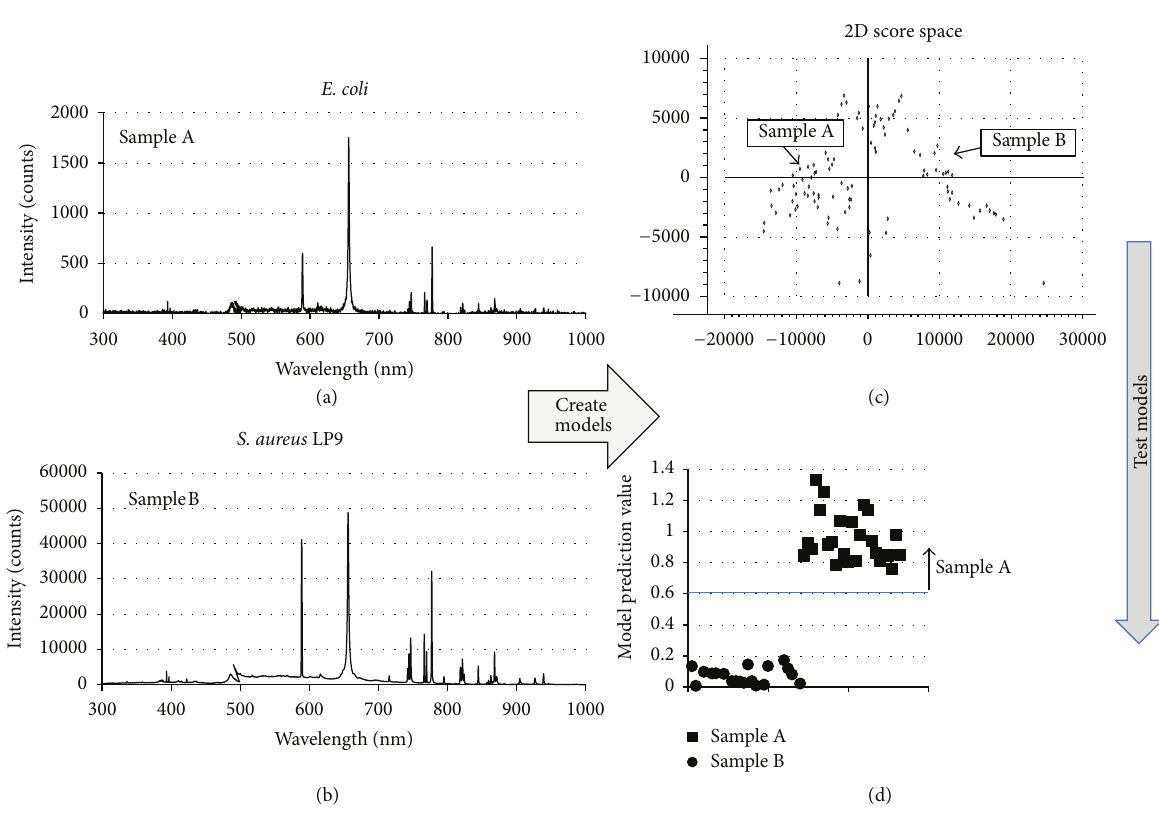
Figure 1: (a), (b) Examples of LIBS spectra used to create a discrimination model for E. coli and S. aureus . (c) The two-dimensional score space plot for the resulting model showing discrimination between the sample types. (d) The prediction values obtained by testing the model with the verification spectra.